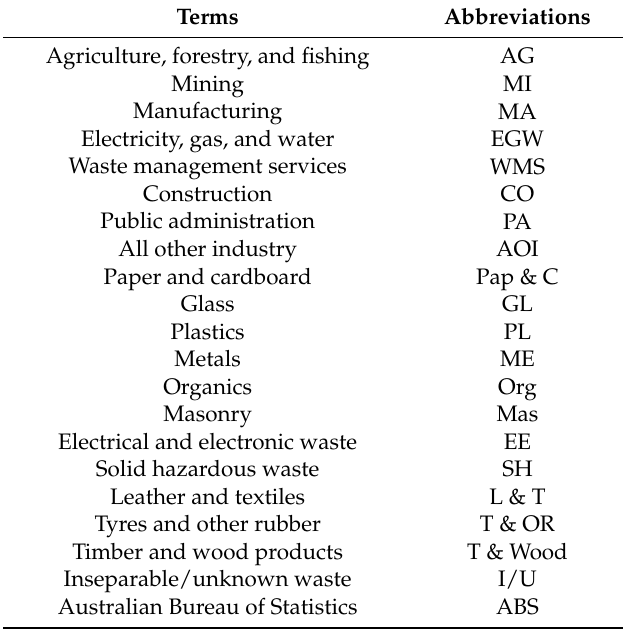
Table 1. The sector terms and their corresponding abbreviations in the study. Terms